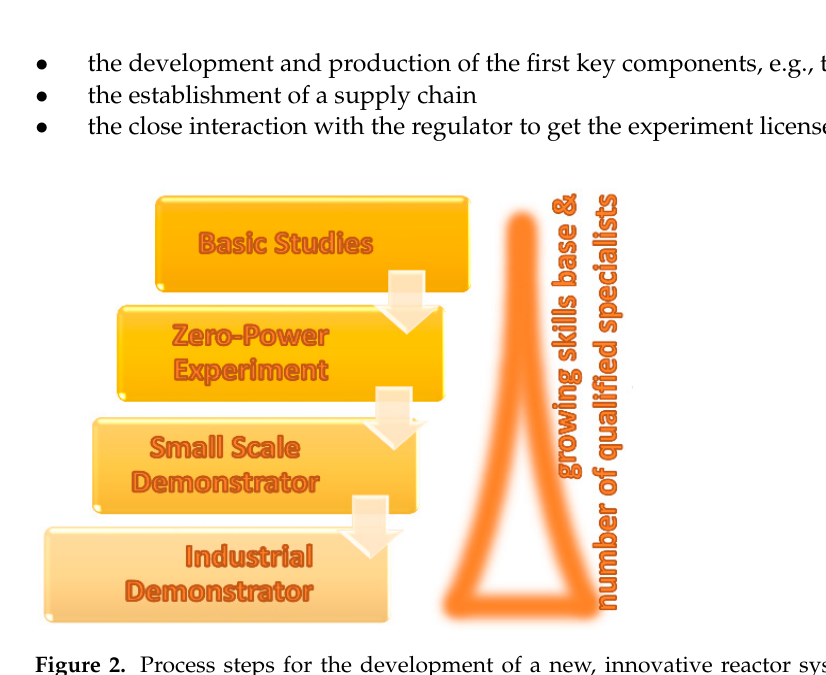
Figure 2. Process steps for the development of a new, innovative reactor system following the approach of [3].